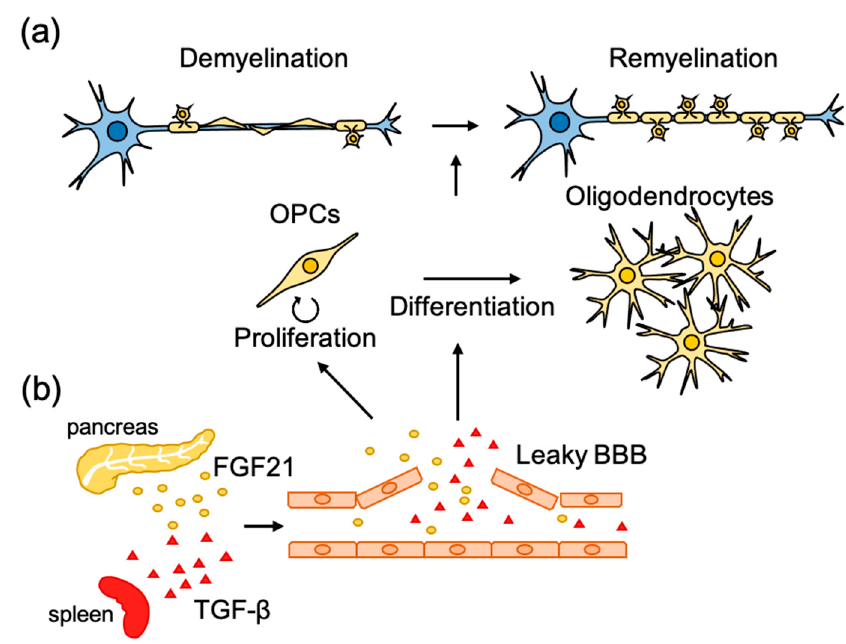
Figure 2. Molecular mechanisms underlying the microenvironmental regulation of remyelination. ( a ) Following injury to myelinated axons, remyelination is initiated with activation and recruitment of oligodendrocyte progenitor cells (OPCs) to the lesion sites. Then OPCs proliferate and differentiate to mature oligodendrocytes to form new myelin sheets. ( b ) Disruption of the blood–brain barrier (BBB) often occurs in CNS lesion sites. Systemic factors leaked from BBB also have beneficial effects on remyelination through promoting OPC proliferation and differentiation.